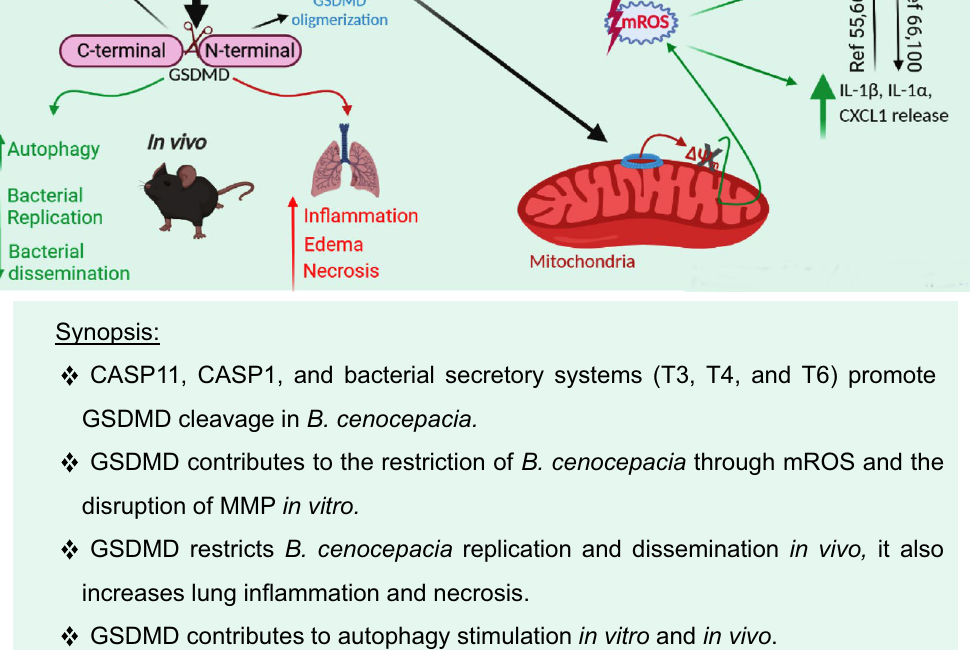
Figure 7. Schematic illustration of the interplay between GSDMD, mROS, autophagy, cytokines release and B. cenocepacia restriction. T: type, CASP11: Caspase11, CASP1: Caspase1, GSDMD: Gasdermin D, IL-1β: Interleukin-1β, IL-1α: Interleukin-1α, CXCL1: C-X-C Motif Chemokine Ligand 1, mROS: mitochondrial reactive oxygen species, ΔΨm: mitochondrial membrane potential, Ref: